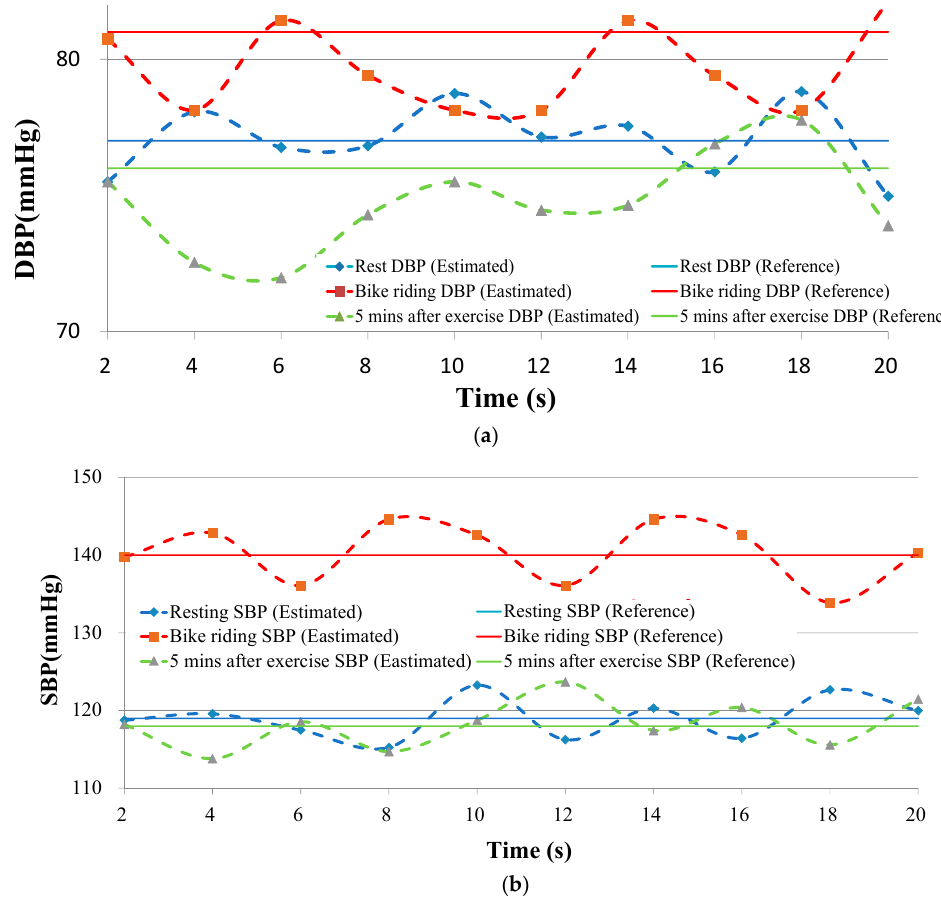
Figure 13. Estimated and reference BP versus time. ( a ) DBP and ( b ) SBP.